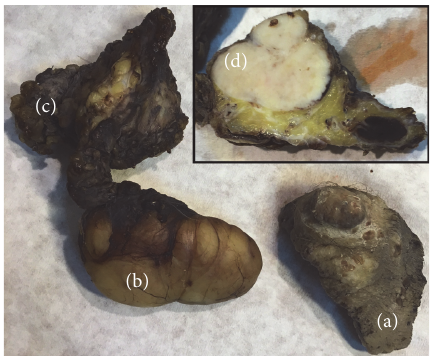
Figure 4: A composite picture showing (a) a recurrent nodule on the surface of the excised scrotal segment (low right part); (b) the incidental lipoma (low left part); (c) the fibrofatty inguinal tissues (upper left part); (d) cut surface of the fibrofatty tissues showing the largest inguinal lymph node being replaced totally by the white malignant metastatic tumor (inset right upper